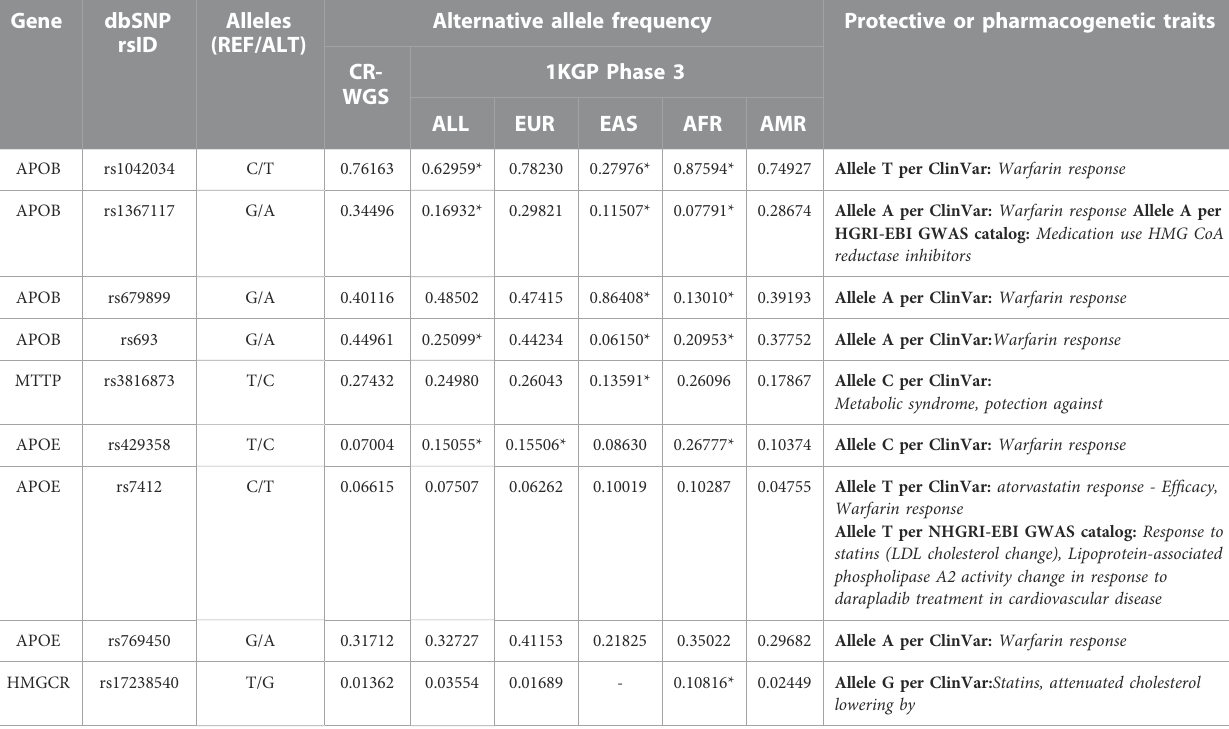
TABLE 4 Variants found in genes of interest that are associated phenotypically with pharmacogenomic or protective traits against diseases. CR-WGS: Costa Rican genomes evaluated in this study, ALL: all Subjects from 1KGP phase 3,EAS: East Asia, EUR: Europe, AFR: Africa, AMR: Latin America. * Signi fi cantly different allelic frequency ( p < 0.05) compared to